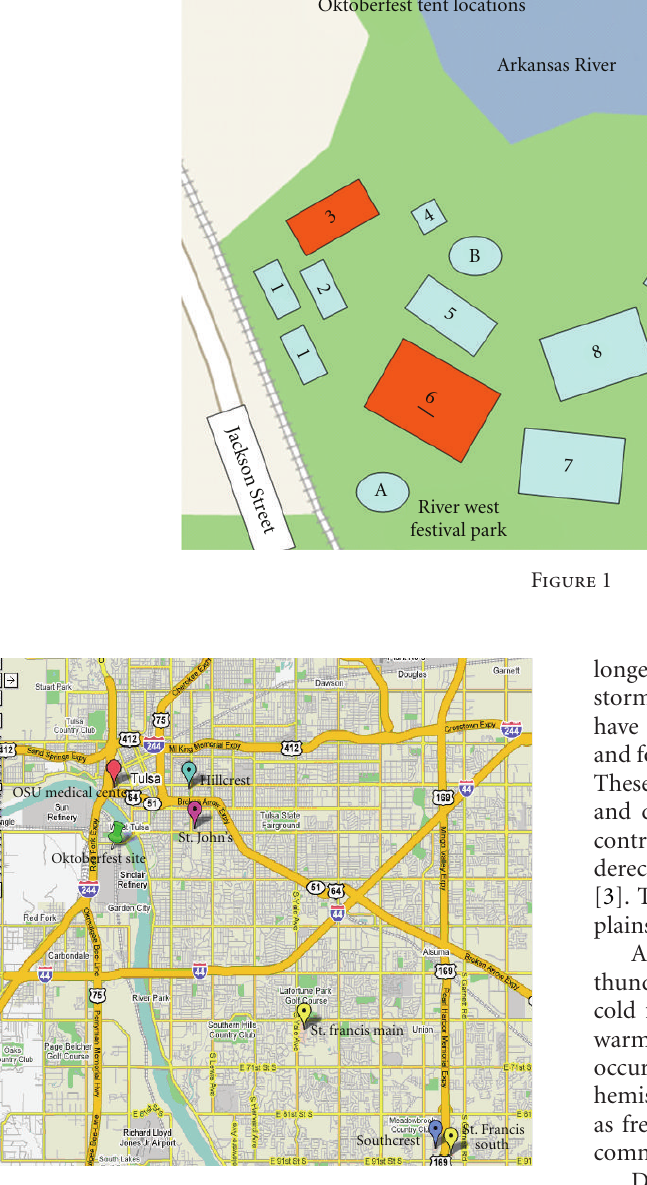
Figure 2: Legend: red = OSU Medical Center, light blue = Hillcrest Medical Center, maroon = St. John’s Medical Center, yellow = St. Francis Hospital (Main) on Yale Avenue, yellow = St. Francis Hospital (South) at bottom of map, dark blue = Southcrest Hospital, Green “tack” = site of Oktoberfest